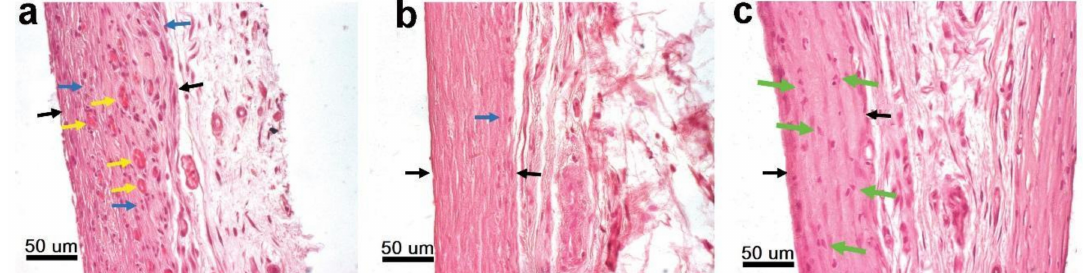
Figure 10. Reduction in lymphocytic infiltration and the formation of a connective tissue capsule around uncoated Ti-alloy after 1 month ( a ) and 3 months ( b ) of implantation. Destruction of lymphocyte nuclei in the fibrous capsule surrounding Ag/Pt samples (green arrows) ( c ). Black arrows—capsule border, blue arrows—accumulations of lymphocytes, yellow arrows—newly formed blood